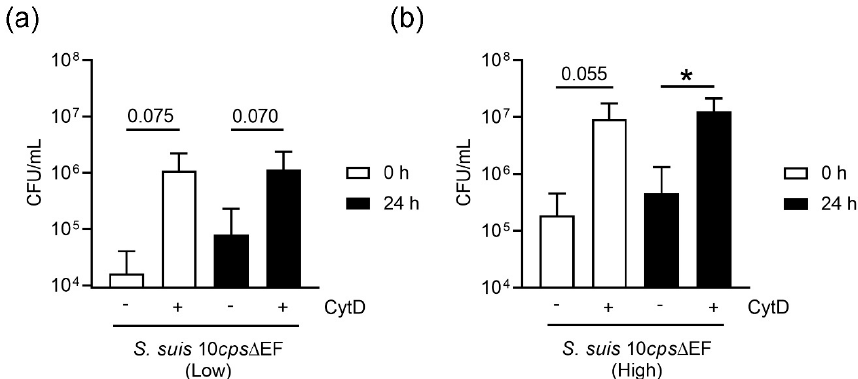
Figure 8. Storing the blood did not significantly influence the phagocytic activity of cells in whole blood. Phagocytosis was blocked by adding cytochalasin D (CytD). Two different initial infection doses were used: ( a ) A low infection dose = 1.5 × 10 5 CFU / mL and ( b ) a high infection dose = 1.5 × 10 6 CFU / mL). Data were analyzed with one-tailed paired Student’s t -test ( n = 4) and are presented with mean ± SD (* p < 0.05). The y -axis is formatted to log